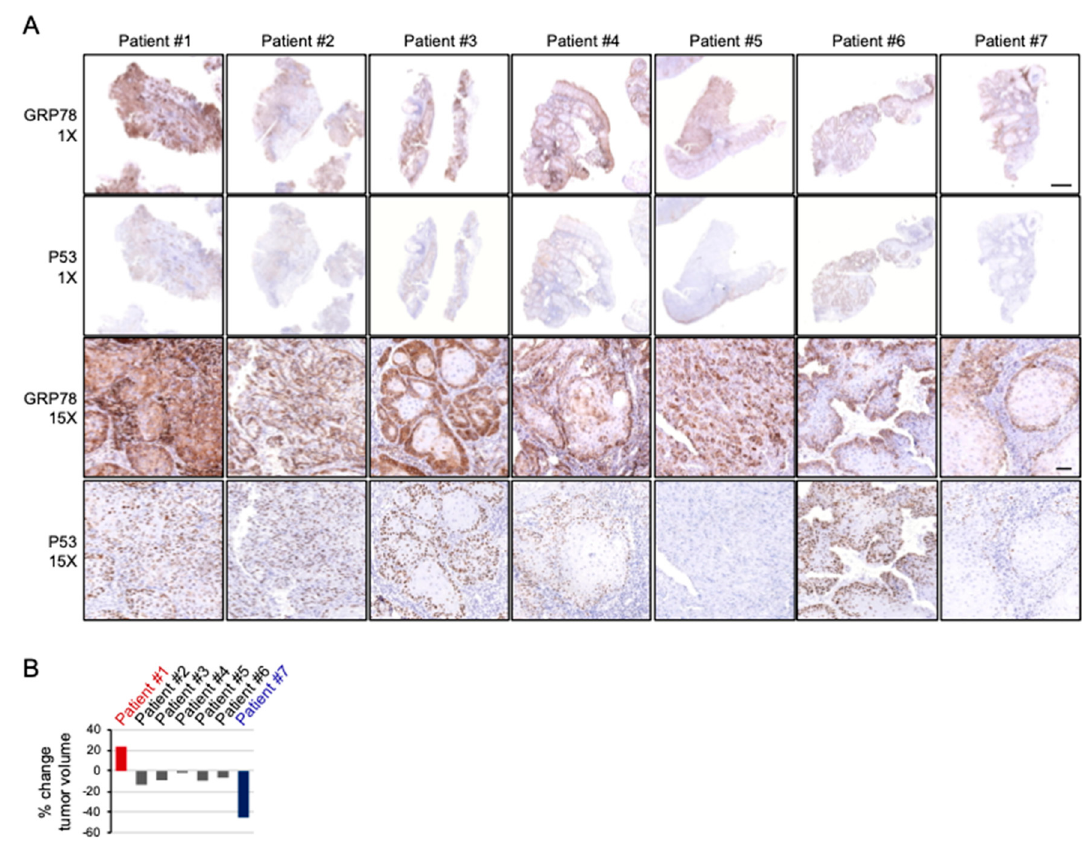
Figure 7. The pattern and intensity of GRP78 positivity coincides with nuclear p53 on immunostaining and is associated with the response to cisplatin-based chemotherapy. ( A ) Whole biopsies and representative GRP78 and p53 immunostaining of specimens of oral cancers taken before cisplatin-based induction chemotherapy. Dominant p53 nuclear staining coincides with the area of strong GRP78 positivity except for patient #5. ( B ) The percentage of relative tumor volume change of patients after two courses of induction chemotherapy. Patient #1 shows progression (23%) and patient #7 shows regression (45%) markedly after treatment. Scale bar: 2 and 0.1 mm for 1 × and 15 × , respectively. Table 1. Clinico-pathological features of oral cancer patients with cisplatin-based chemotherapy prior to surgical treatment.